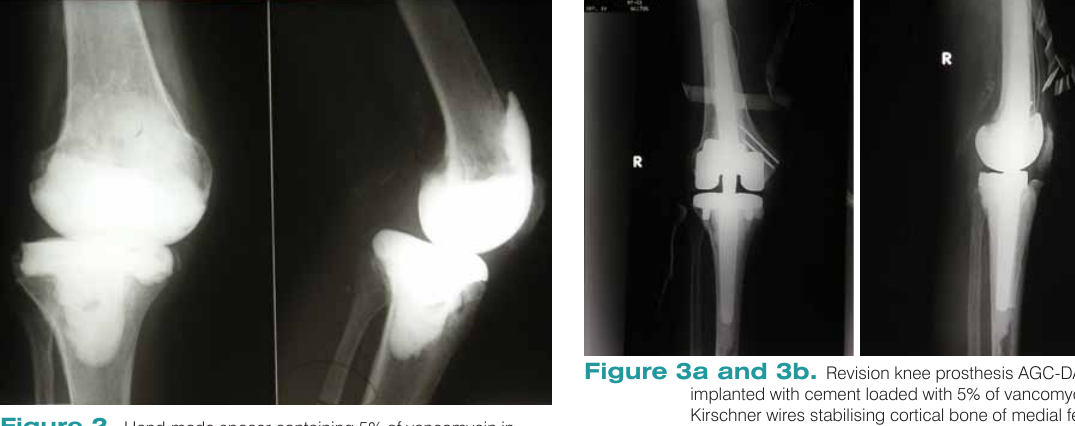
Figure 2. Hand-made spacer containing 5% of vancomycin in 120 g of acrylic cement.